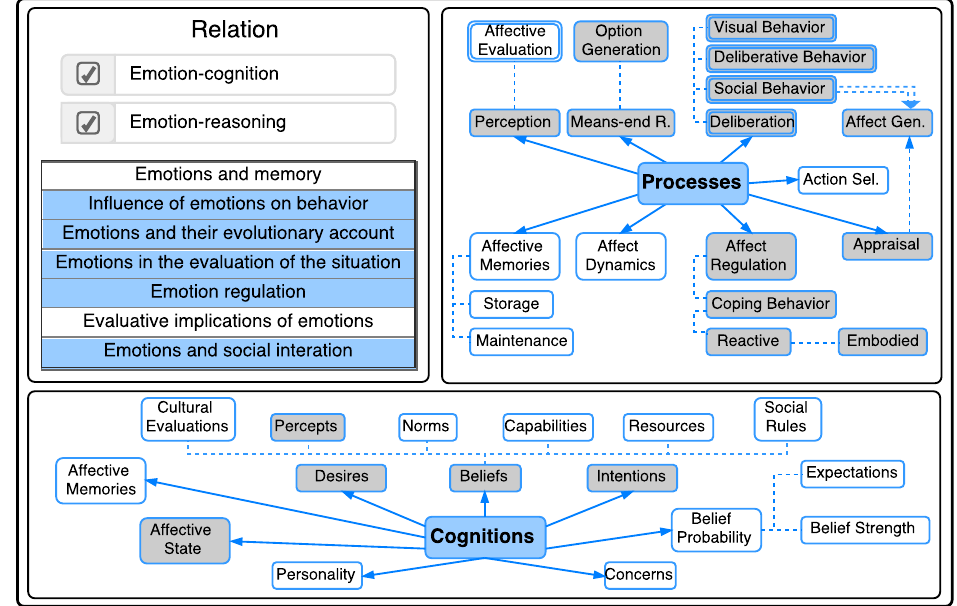
Figure 6. Processes and cognitions of the emotion model of the infant